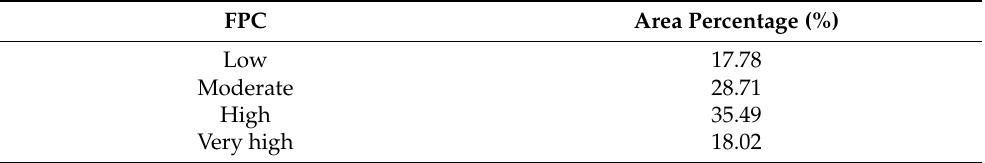
Table 4. Area statistics corresponding to FPC grades.